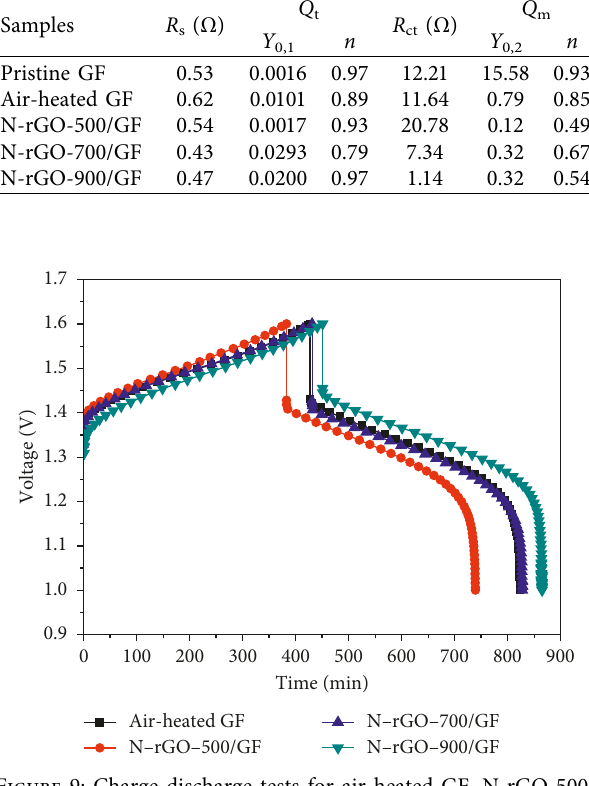
Figure 9: Charge-discharge tests for air-heated GF, N-rGO-500/